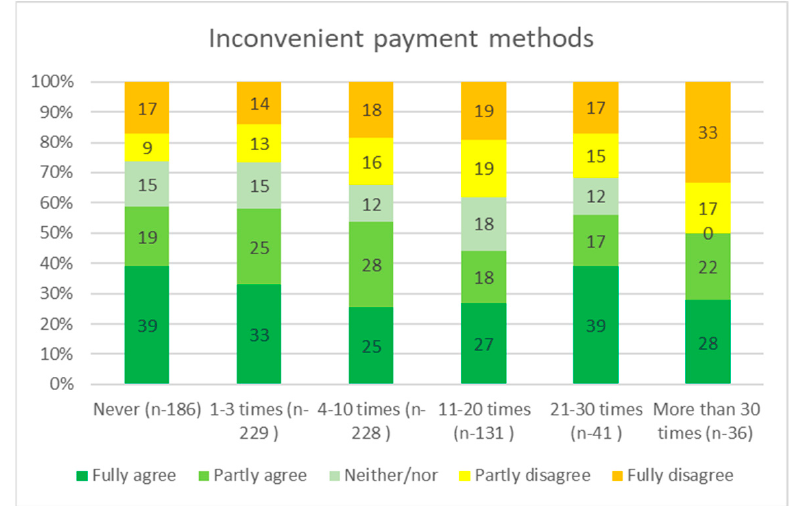
Figure 2. Distribution showing BEV owners’ level of agreement to the statement “ I find payment solutions at fast-charging stations inconvenient ”, according to the number of times the respondents have used public fast chargers the last 12 months ( n -851).